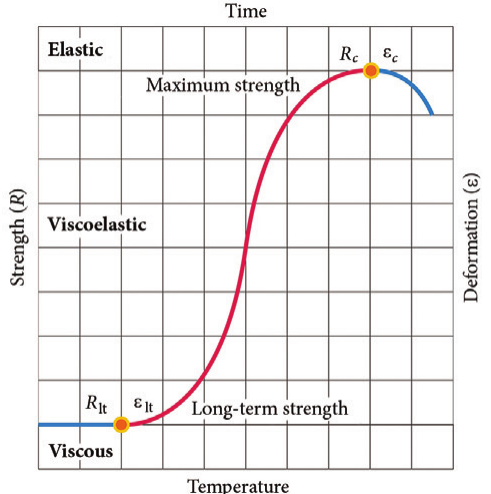
Fig.2. Characteristics of asphalt concrete depending on the temperature (time of